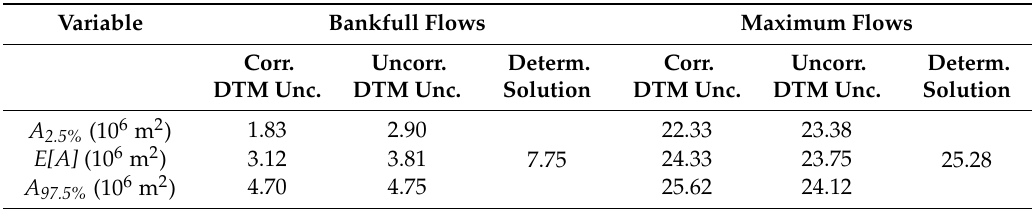
Table 2. The effect of elevation uncertainty on calculated inundation areas for high and near bankfull flows.